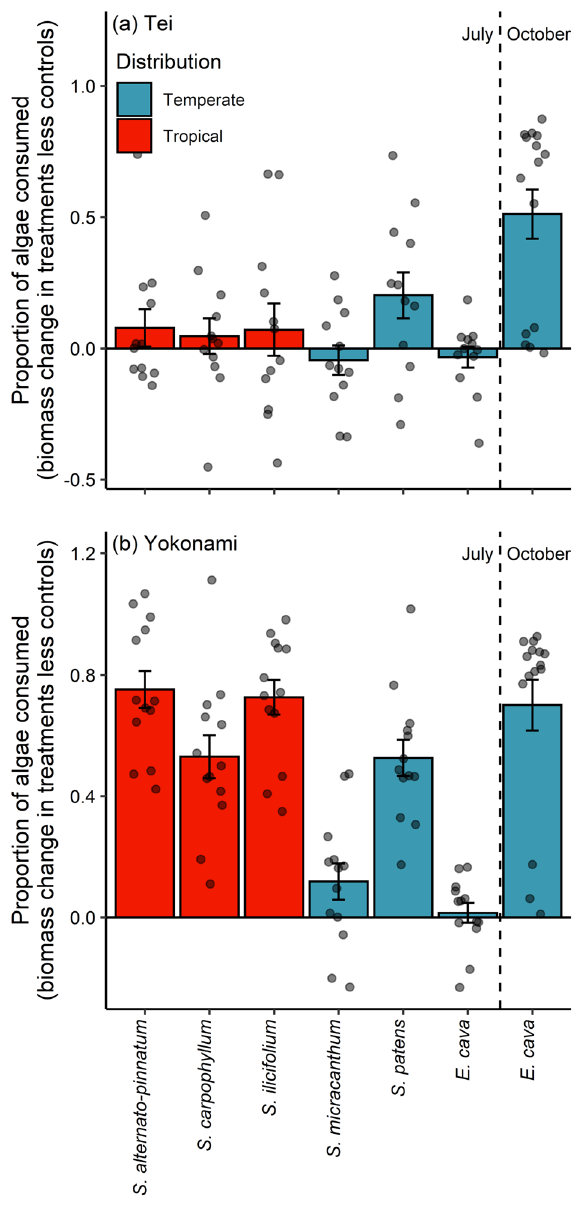
Figure 2. The proportional biomass loss from each seaweed species during feeding trials in ( a ) Tei and ( b ) Yokonami. Bars are the mean (± SE) algal biomass lost in treatments minus the algal biomass most in paired controls for each algal species and dots are the raw